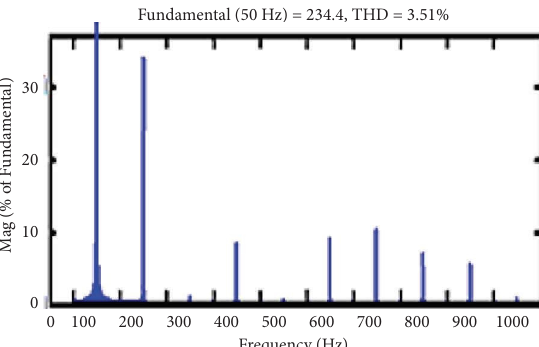
Figure 11: FFT analysis of voltage.